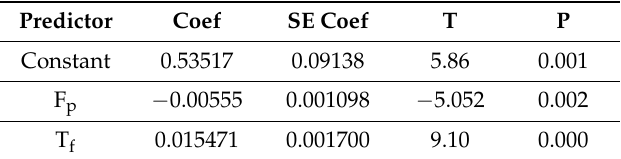
Table 7. Regression equation coefficients.